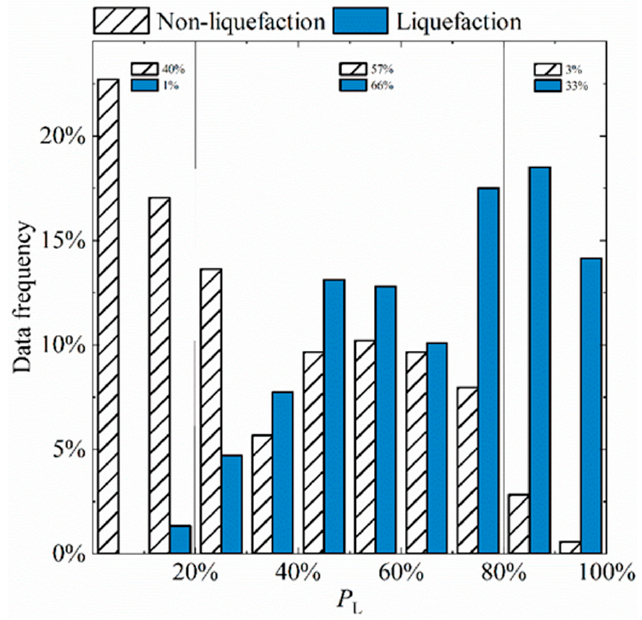
Figure 3. Histogram of P L versus data frequency for preliminary classification.